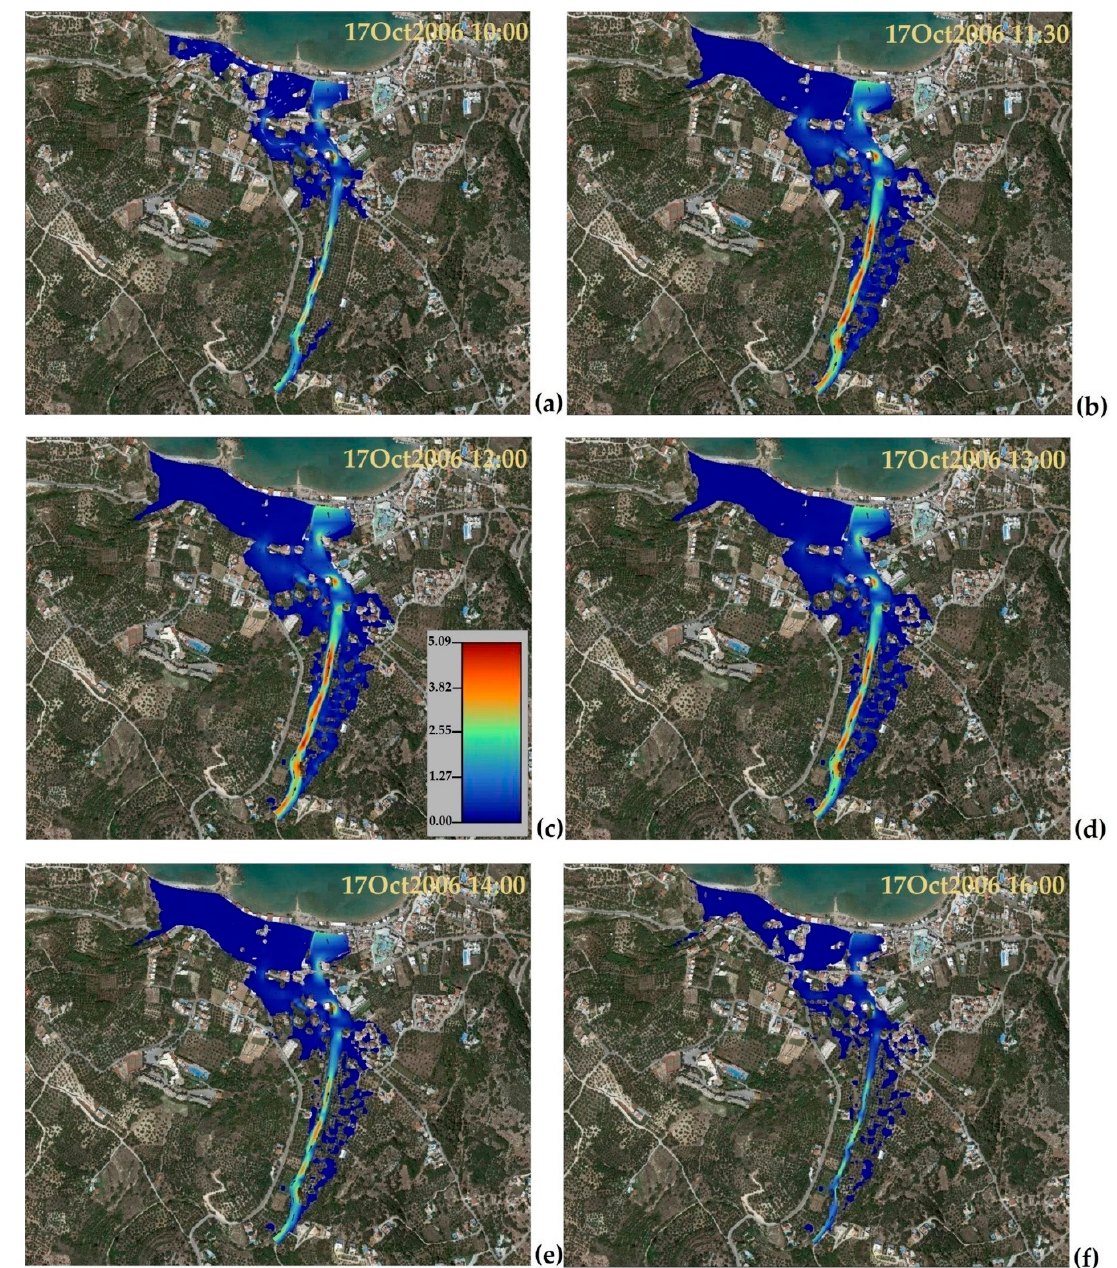
Figure 7. Modeled velocities (m/s) at ( a ) 10:00, ( b ) 11:30, ( c ) 12:00, ( d ) 13:00, ( e ) 14:00, and ( f ) 16:00 of 17 October 2006, by using the coupled 1D/2D HEC-RAS model, at high resolution DEM 5 m × 5 m.